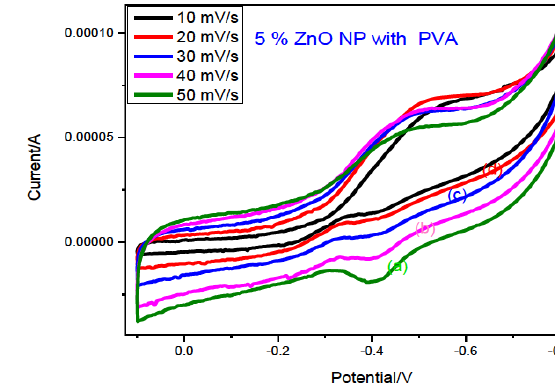
that the difference in the peak potentials ∆ E a , c is compar- atively lower for 13% ZnO/PVA composite (Table